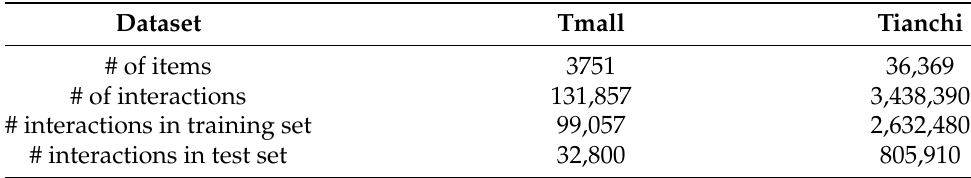
Table 2. Dataset